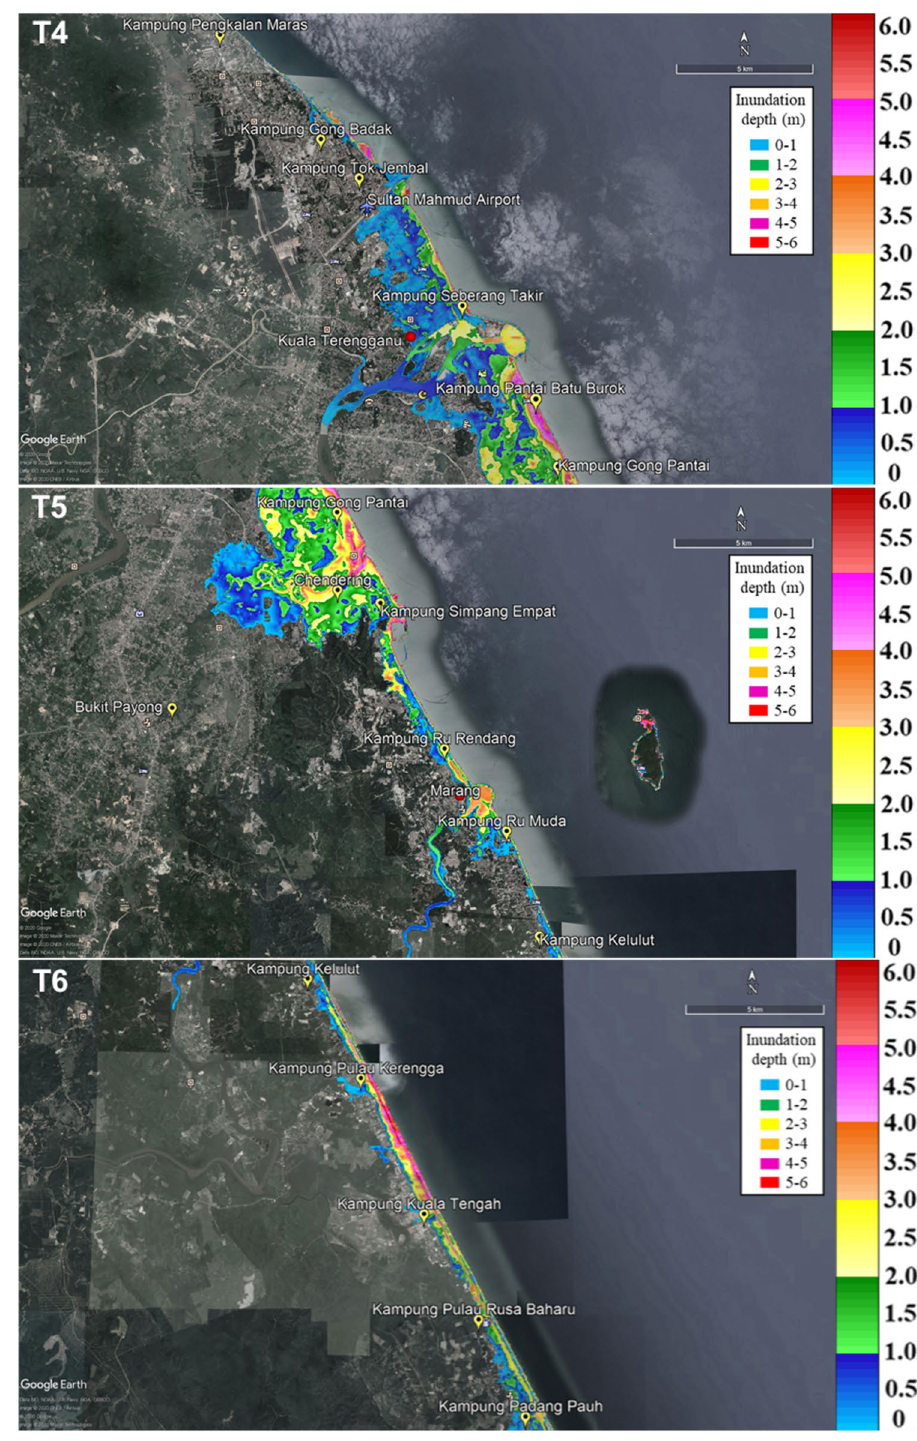
Fig. 8 Inundation map